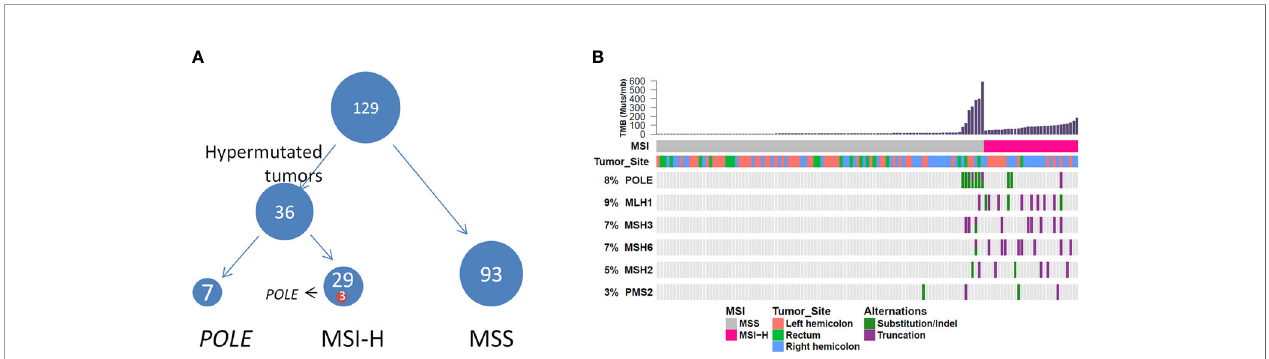
FIGURE 4 | (A) Hypermutated tumors include MSI-H tumors and tumors harboring POLE mutations. (B) Genomic landscape showing associations among MSI-H, microsatellite instability, high TMB, MSI status, and POLE mutation. TMB, tumor mutational burden.